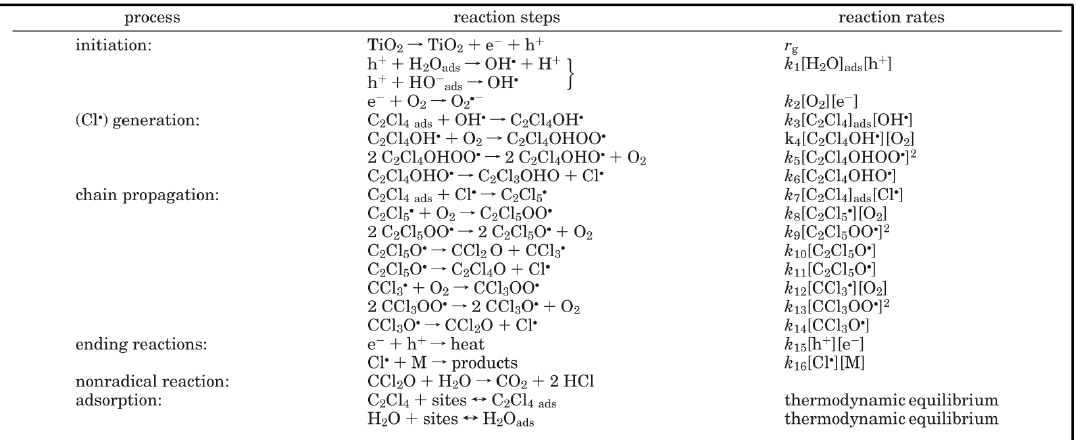
Figure 13. Reaction mechanism for the degradation of tetrachloroethylene as proposed by Imoberdorf et al. (2005). Adapted with permission from Reference [83], Copyright (2005), American Chemical Society.